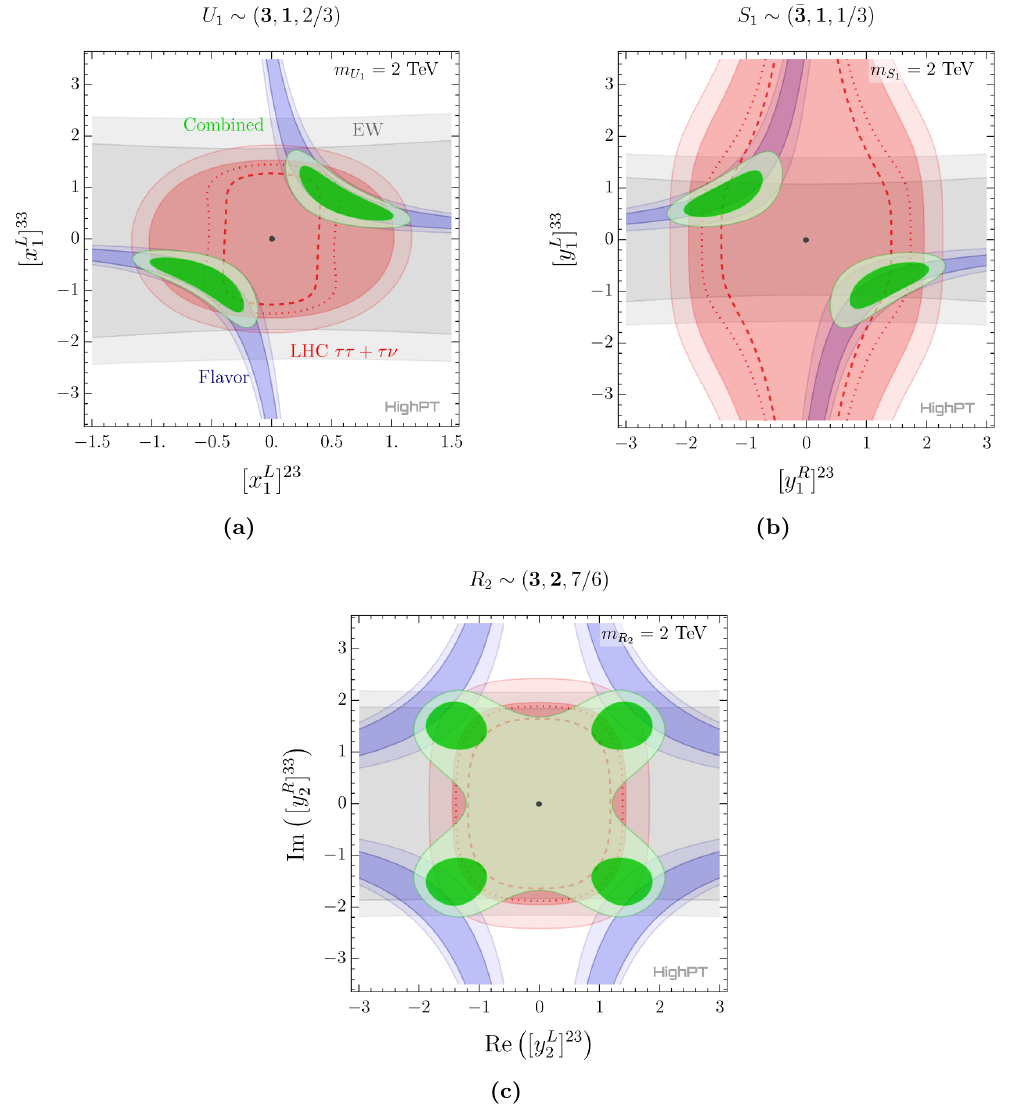
Figure 13. Bounds on the leptoquark couplings from low-energy (blue), electroweak pole (gray) and high- p LHC (red) observables. The combined fit is shown in green. For every bound we show T the 1 σ and 2 σ regions. The dashed (dotted) red line indicates the projection of the 1 σ ( 2 σ ) region for an integrated luminosity of 3 ab − 1 . The leptoquark masses are set to Λ = 2 TeV. The minimum values for the combined χ 2 in our fits are given by χ 2 = 26 . 4 ( a ) , 30 . 0 ( b ) , 38 . 6 ( c ) min